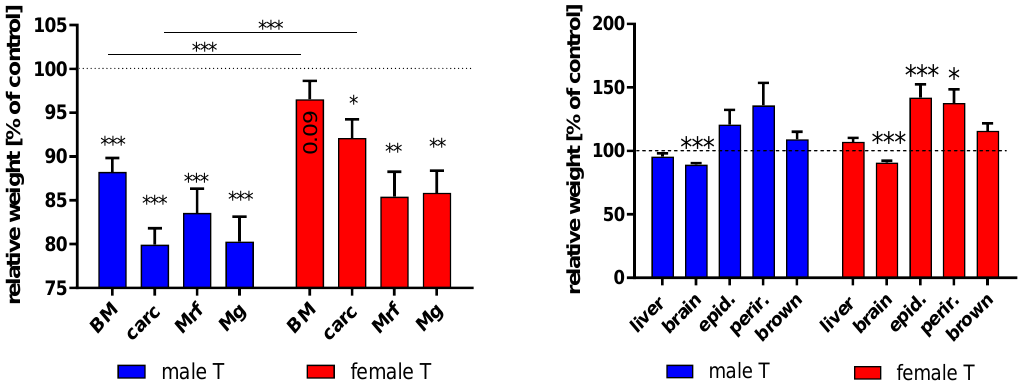
Figure 2. Body and organ weights in male and female IGFBP-2 transgenic mice (DU6P / C57BL / 6) in percent of non-transgenic littermates at the age of 7 weeks (mean ± SEM; n = 14 for each group; *: p < 0.05; **: p < 0.01; ***: p < 0.001; BM: body mass; carc: carcass mass; Mrf: mass of Musculus rectus femoris; Mg: mass of Musculus gastrocnemius; epid.: epididymal fat mass; perir.: perirenal fat mass; brown: brown fat mass).